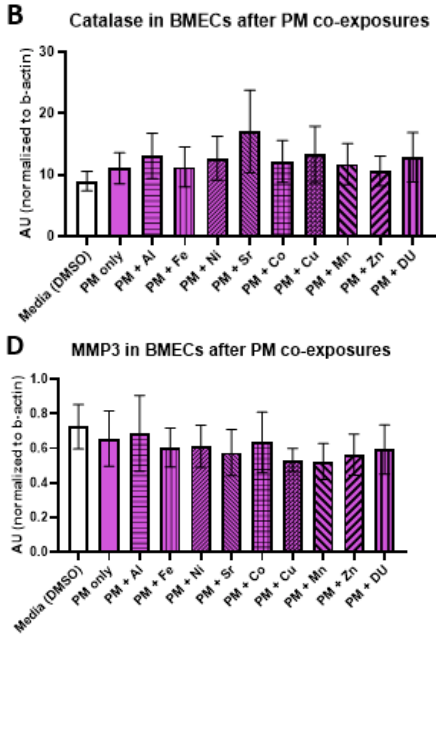
13 of 19 Figure 6. Oxidative stress proteins in brain microvascular endothelial cell (BMEC) cultures after pyridostigmine bromide (PB) and metal exposure. Assessment of several oxidative stress related protein levels in BMEC cultures after exposure to PB (10 µM) and metals (1 µM). ( A ) GPX4 expression,